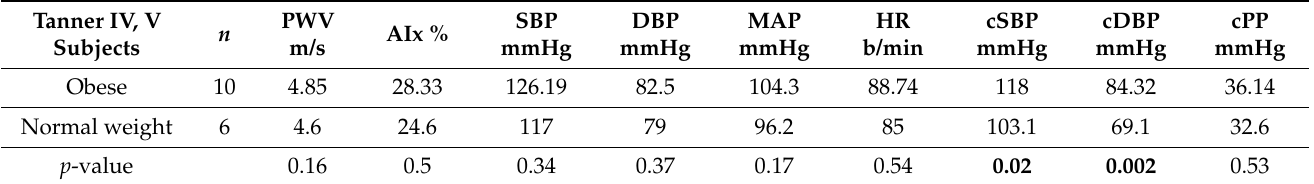
Table 12. PWA parameters comparison in Tanner Stage IV and V subjects.